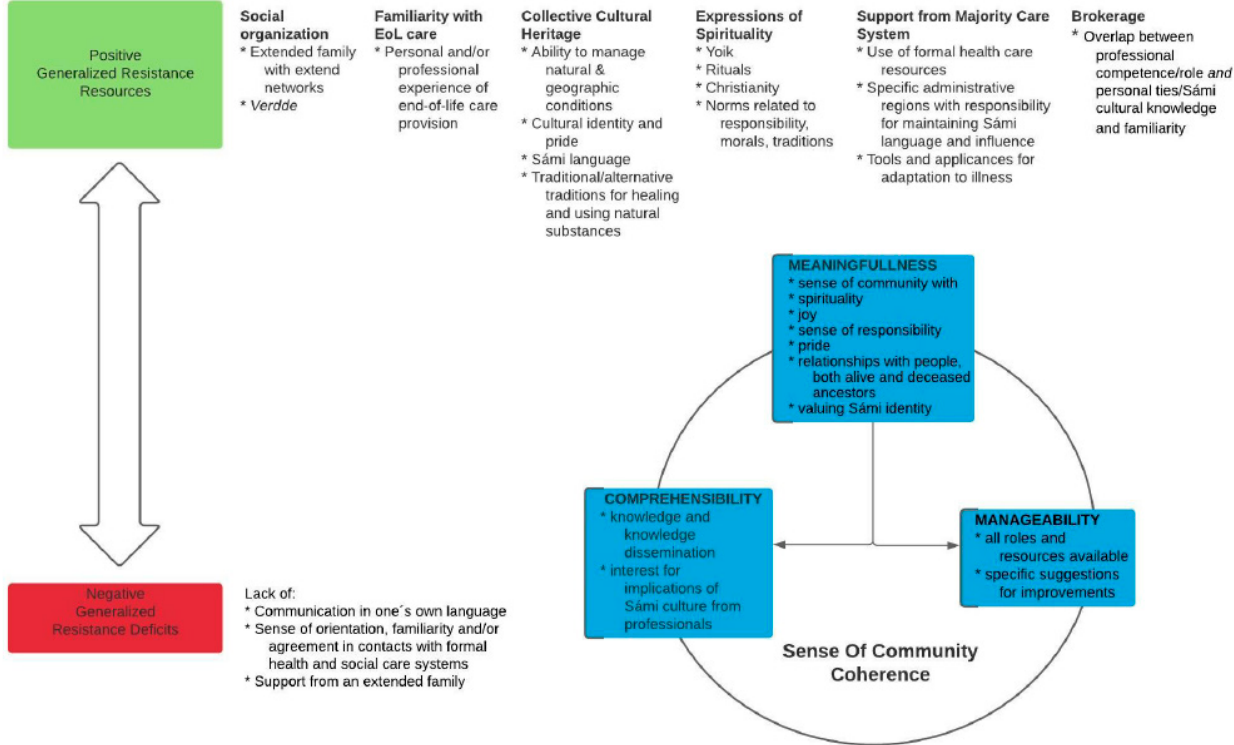
Figure 2. Graphic representation of a description and interpretation of the